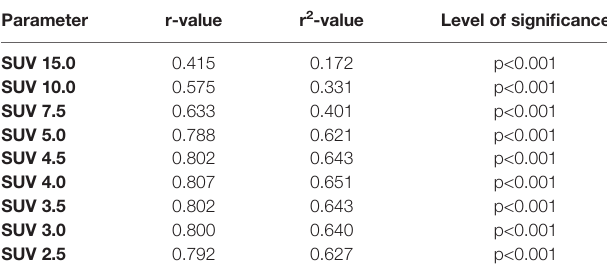
TABLE 1 | Correlation with fi xed SUV thresholds.